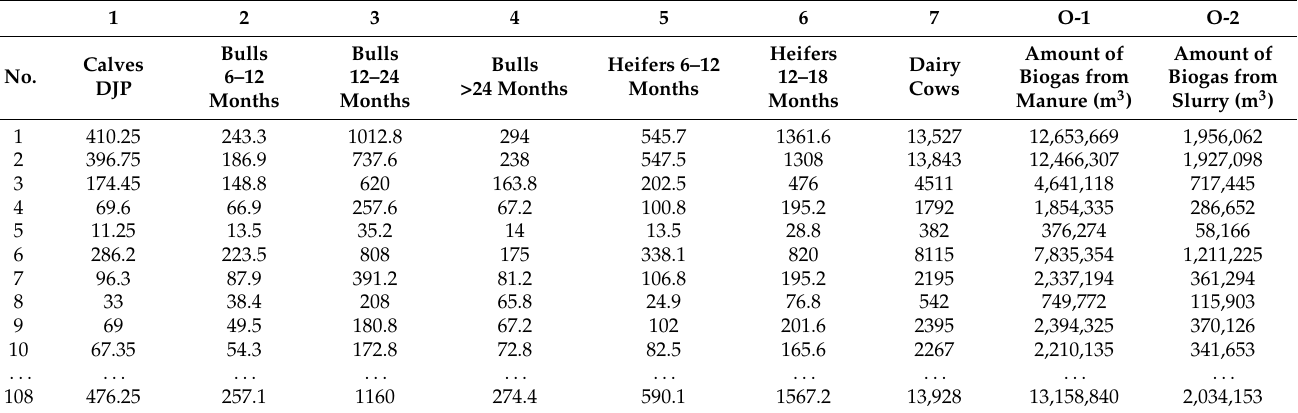
Table 3 shows the exemplary structure of training file for Podlaskie voivodeship. Table 3. The exemplary structure of training file for Podlaskie